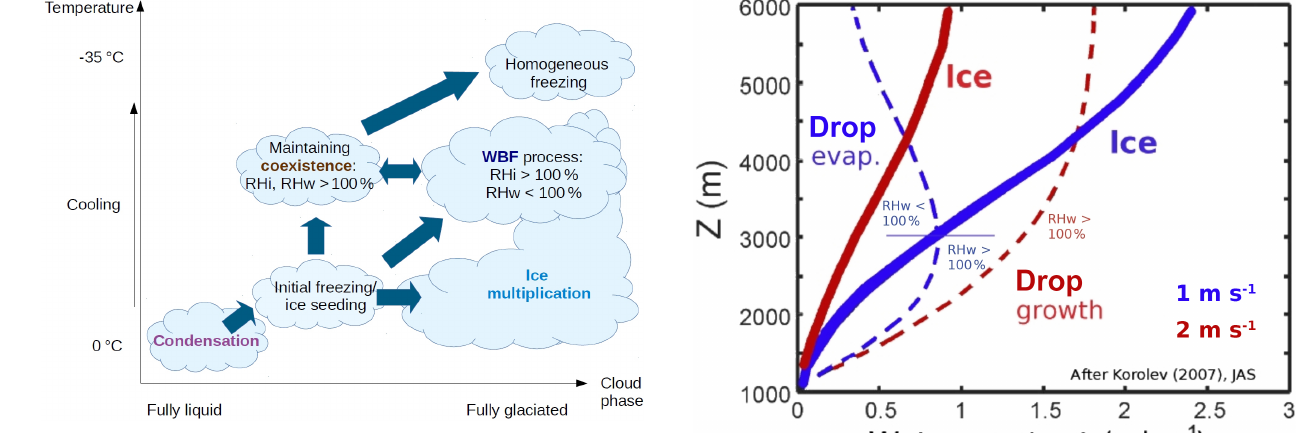
Figure 1. Possible paths to glaciation in the mixed-phase tempera- ture regime.